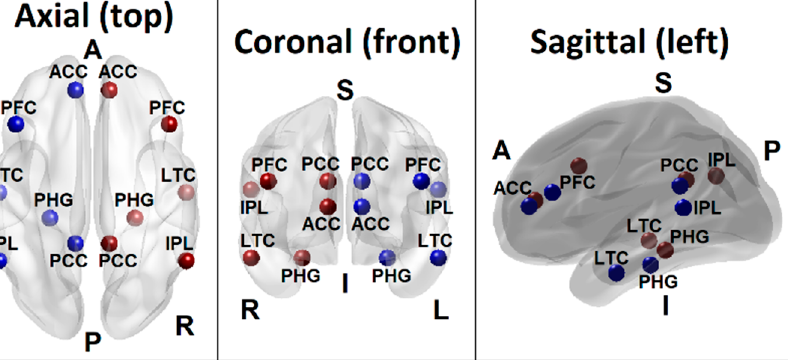
Figure 1. Seed regions of the default mode network (DMN) consisting of 6 regions in the left hemisphere (blue beads) and 6 homologous regions in the right hemisphere (red beads) as listed in Table 2. Axial (top), coronal (front), and sagittal (left) views are shown. [PCC–Posterior